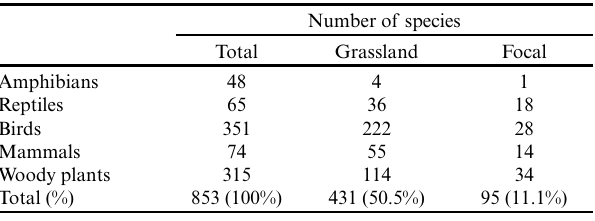
Table 1 . Species richness of terrestrial vertebrates and woody plants of Uruguay. For each group, the total number of species in the country (Total), the number of species using grassland as habitat (Grassland species) and the number of Grasslands species prioritized at the national level in Uruguay (Focal species) are given. Number of species Total Grassland Focal Amphibians 48 4 1 Reptiles